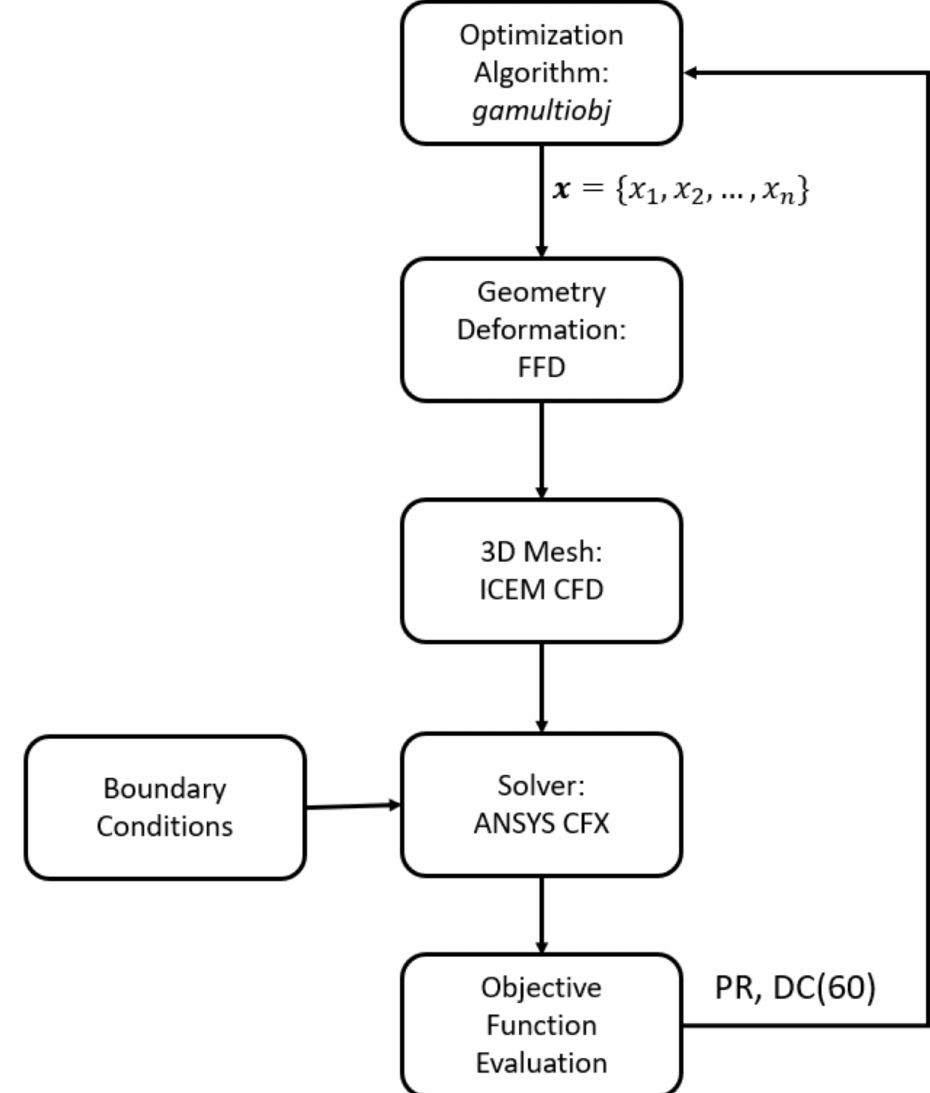
Figure 9. Optimization